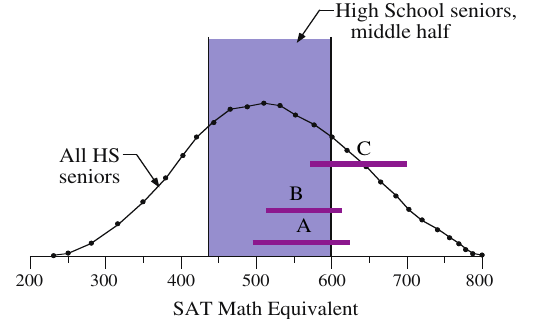
FIG. 7. 25th – 75th percentile of incoming math SAT scores from the three populations, relative to national values. University A is the primary implementation